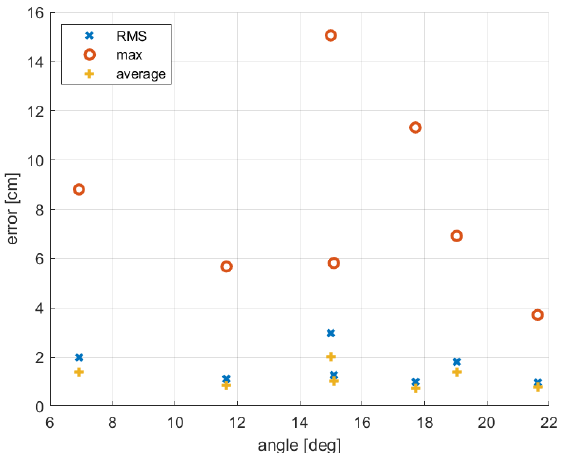
Figure 7. Depth error on a planar surface varying the angle be- tween the normal of the planar surface and the plane orthogonal to the camera observation